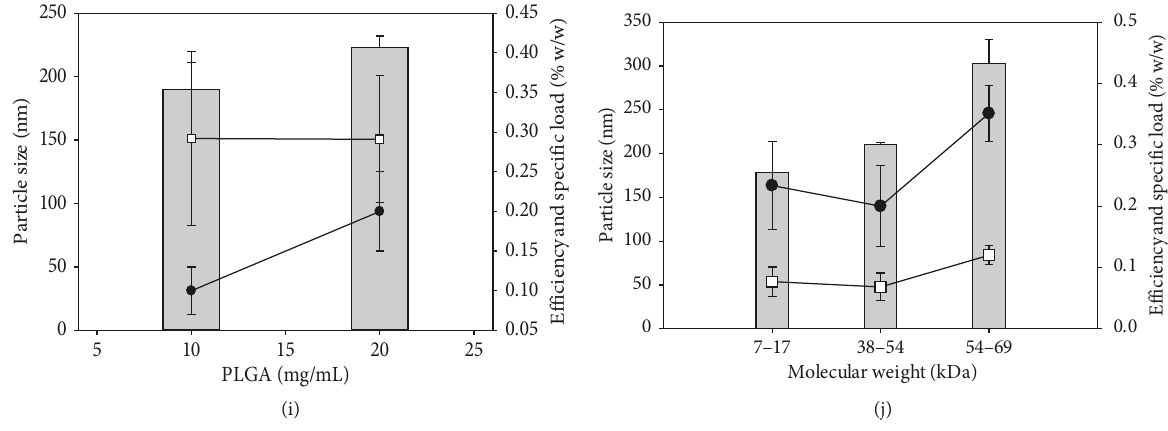
Figure 3: Effects of different variables on the average particle size ( ), entrapment efficiency ( ), and specific load ( ) of PLGA nanoparticles loaded with NAC. (a) Nonsolvent viscosity, (b) aqueous phase pH, (c) solvent and nonsolvent ratio, (d) NAC concentration in acetone, (e) NAC concentration in DMSO, (f) NAC concentration in nonsolvent, (g) solvent type, (h) NAC-calcium salt, (i) polymer concentration, and (j) polymer molecular